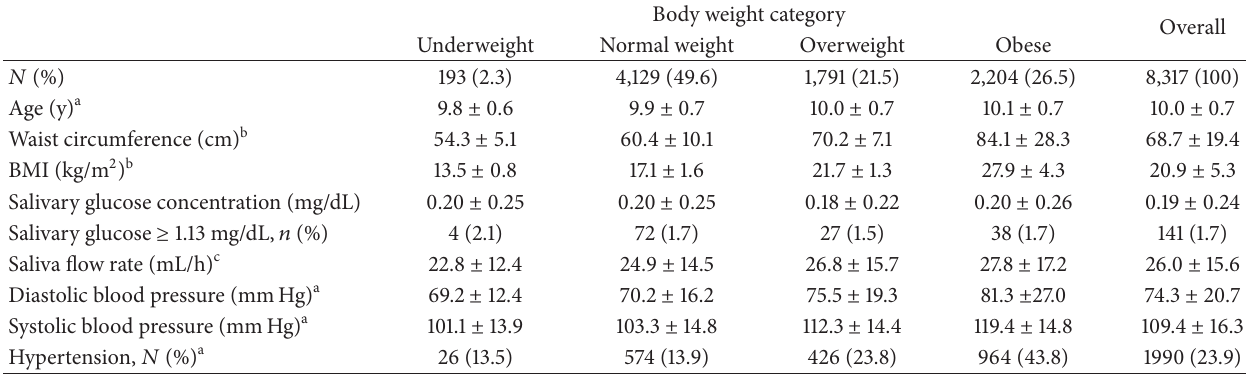
Table 1: Demographic data and clinical characteristics of 8,317 enrolled children overall and by weight